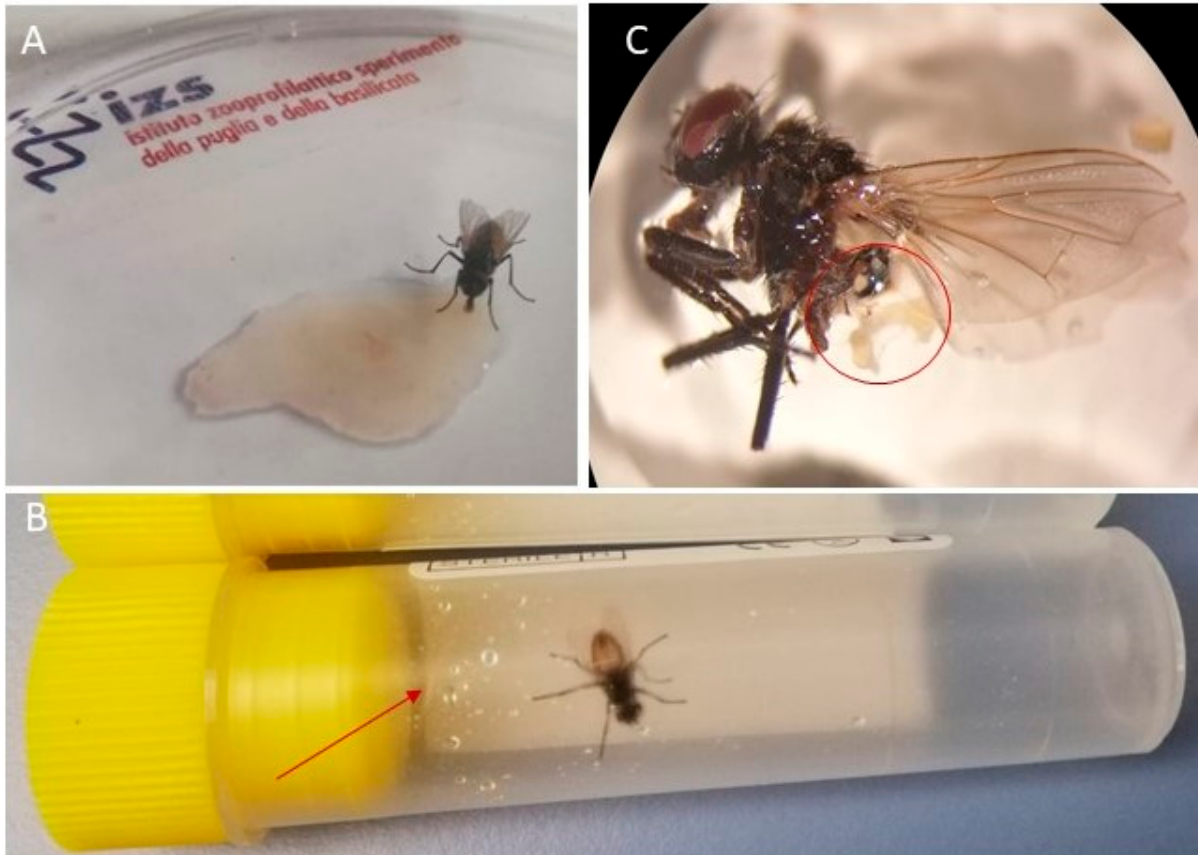
Figure 2. Experiment 3: Housefly contamination by feeding on homogenized ORFV-positive ovine crusts ( A ); housefly spots visible on the walls of the tube test ( B ); dissection of the housefly crop after infective meal ( C ).